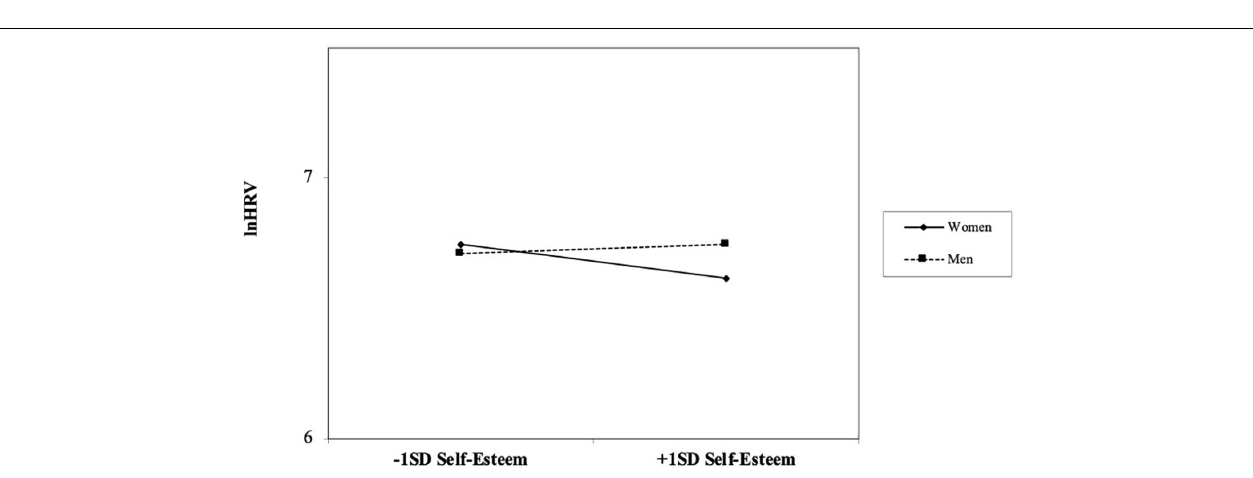
FIGURE 2 | The moderated mediation model with parameter estimates. Self-esteem*Sex = interaction term between self-esteem and sex.